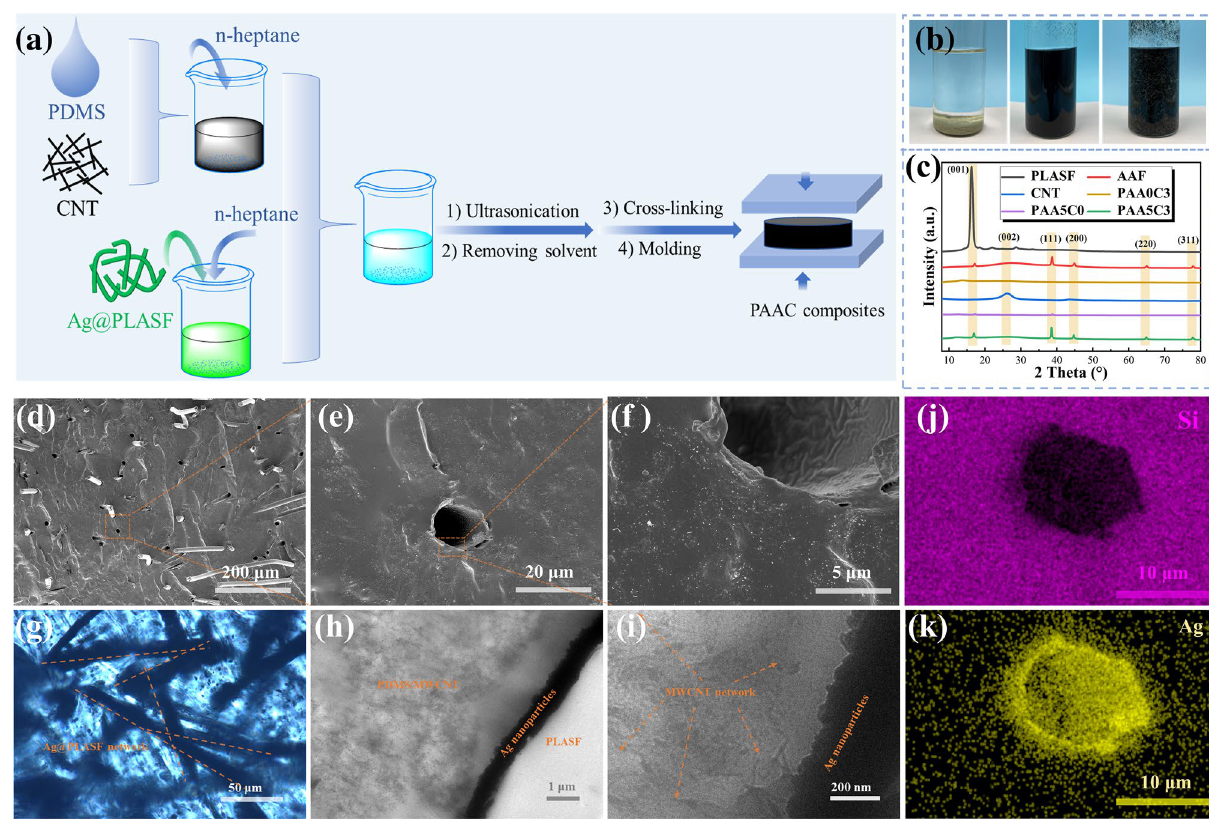
Fig. 2 a Schematic illustration of the fabrication process of PAAC composites; b digital photographs of AAF (left), CNT (middle), AAF/ CNT mixture in the n-heptane (right); c XRD curves of PLASF, AAF, CNT and the composites containing AAF or CNT; d‑f SEM images of PAA3C3; g the POM image and h, i TEM images of PAA3C3 composites with different magnification; j, k EDS images of PAA3C3